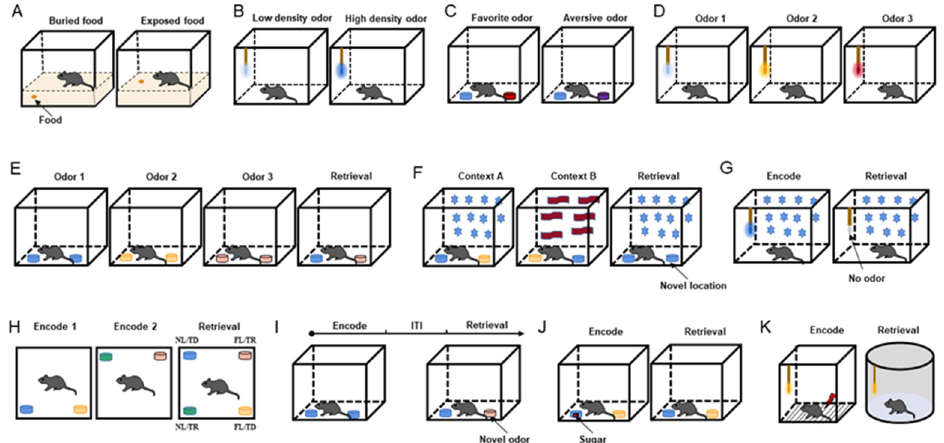
Figure 1. Behavioral paradigms. ( A ) Diagram of food-seeking test. ( B ) Diagram of odor sensitivity test. ( C ) Diagram of odor preference test. Blue is neutral, red is preferred, and purple is aversive. ( D ) Diagram of odor discrimination test. ( E ) Diagram of temporal odor memory test. ( F ) Diagram of spatial odor memory test. Star and wave patterns represent different context decorations. ( G ) Diagram of context odor memory test. ( H ) Diagram of spatiotemporal odor memory test. ( I ) Diagram of context-independent odor memory test. ( J ) Diagram of odor–reward associative memory test. The red square represents sugar cube. ( K ) Diagram of odor–aversion (foot shock) associative memory test. Odorant was applied to the cotton tip ( B , D , G , K ) or odor cup ( C , E , F , H – J ). Different colors of cotton swabs or smell cups represent the presentation of different odors.